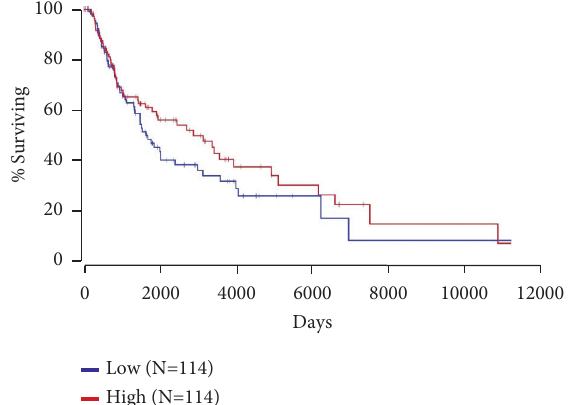
Figure 3: MDM4 expression does not significantly correlate with patient survival. TCGA survival data for skin cutaneous melanoma were separated by the expression of MDM4. The “High” group (red) had the expression of MDM4 in the top 25% of available subjects. “Low” (blue) subjects were in the bottom 25% of expression for MDM4. N for each group is 114 subjects. Kaplan–Meier analysis indicates no significant difference in survival between these groups; log-rank p value � 0.247.